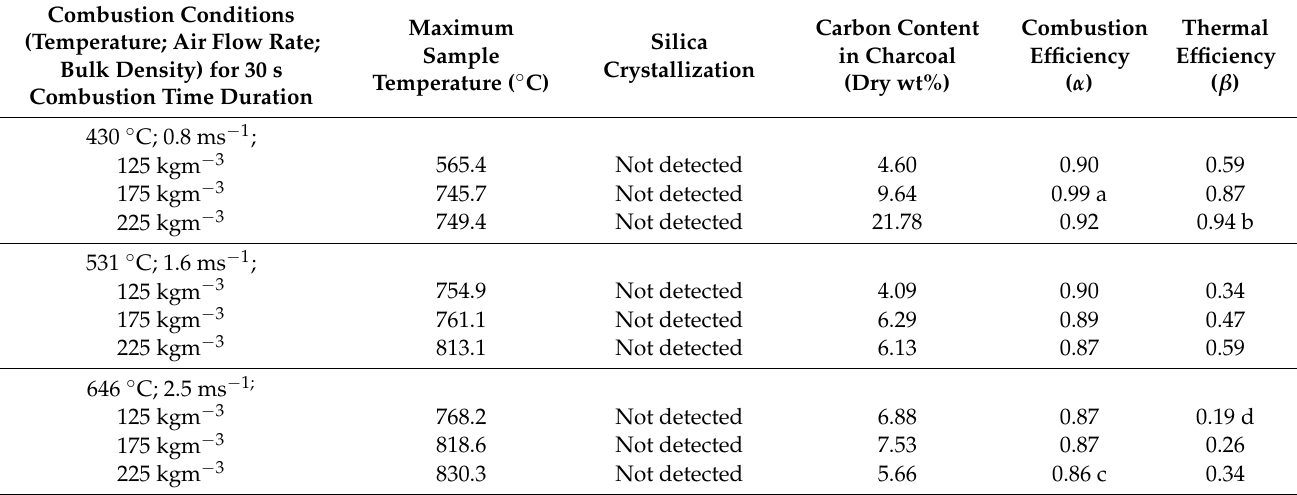
Table 4. Summary of the main combustion experiment